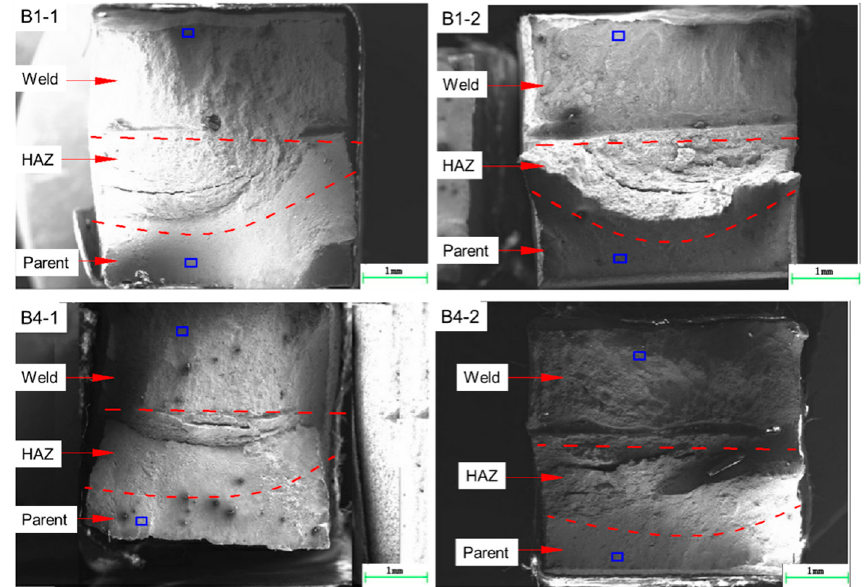
Figure 16. The macro-fracture surface morphologies of SSRT specimens.